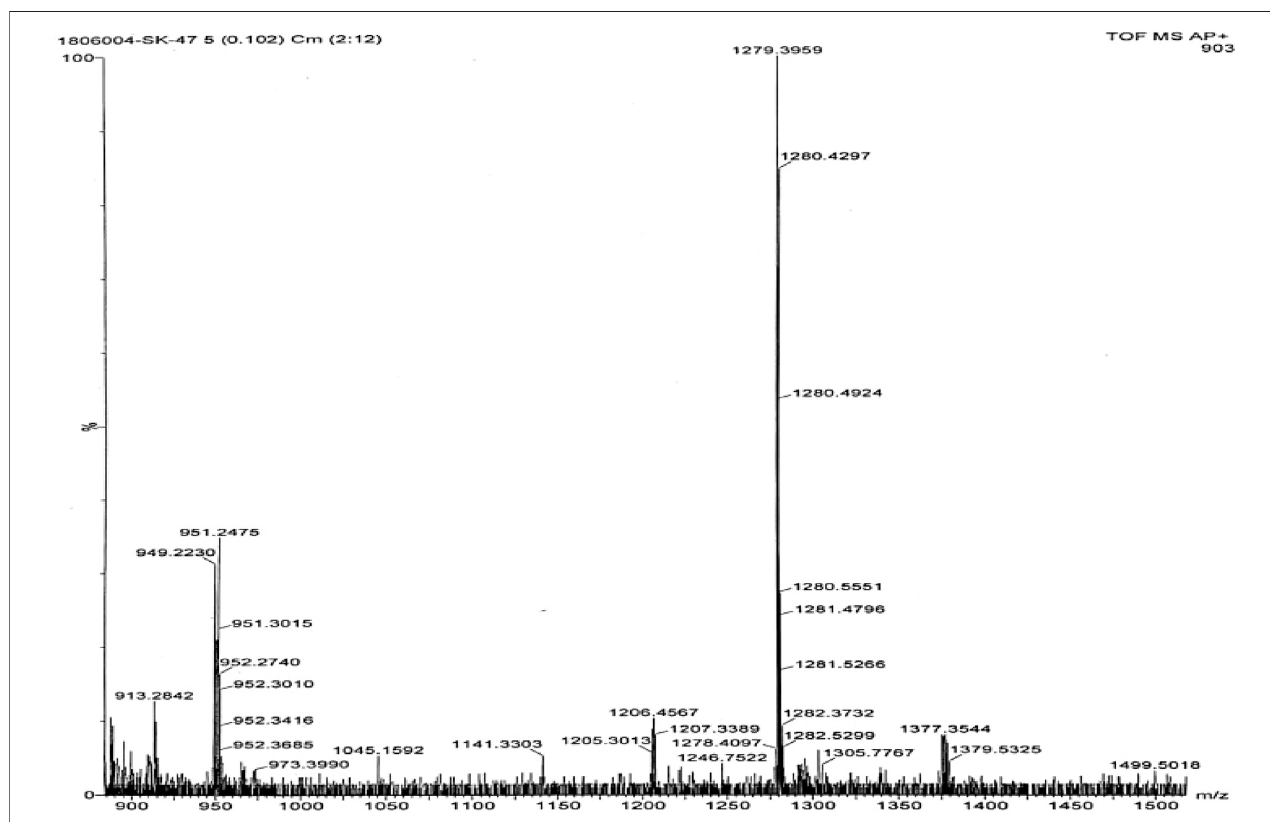
FIGURE 8 | Mass spectrum for phthalocyanine IXd with mass fragment (M-2) (cid:2) 1305.